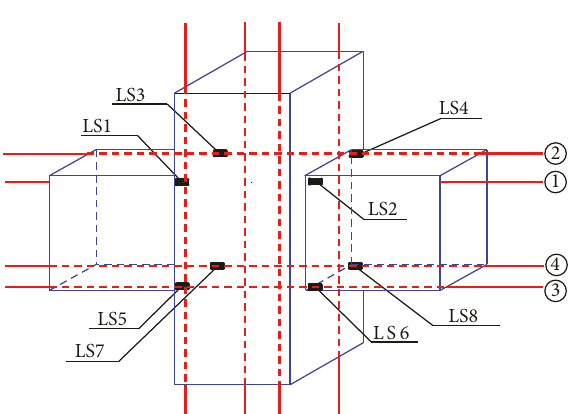
Figure 2: Test setup.